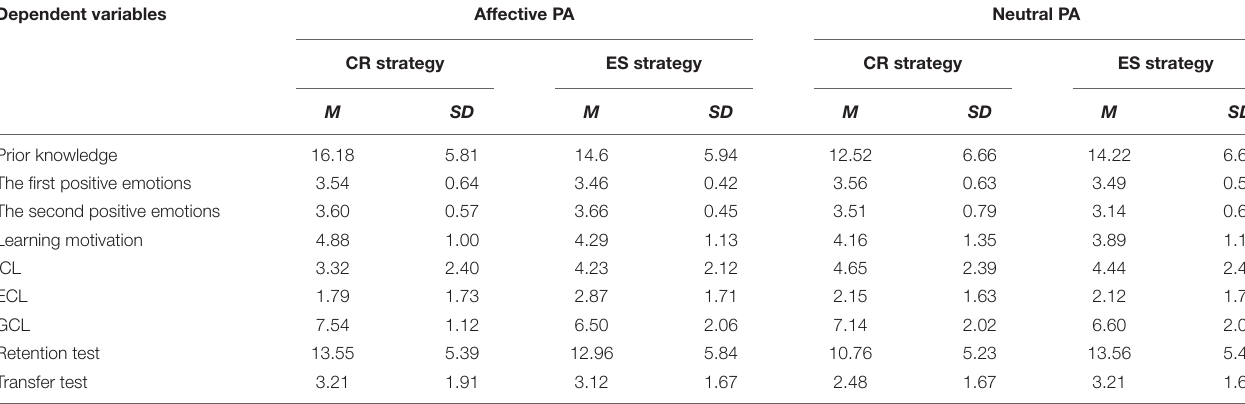
FIGURE 2 | The positive emotions on the first and second measurement point for the two groups in Experiment 1. TABLE 2 | Means and standard deviations of all tests for four groups in Experiment